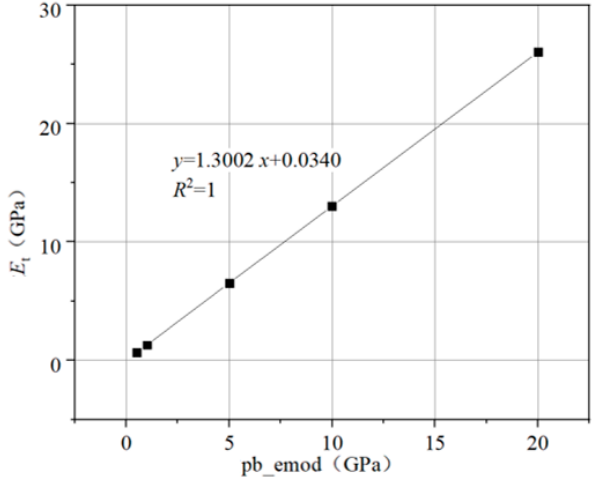
Figure 13. Relationship between the tensile elastic modulus and parallel bonding modulus.